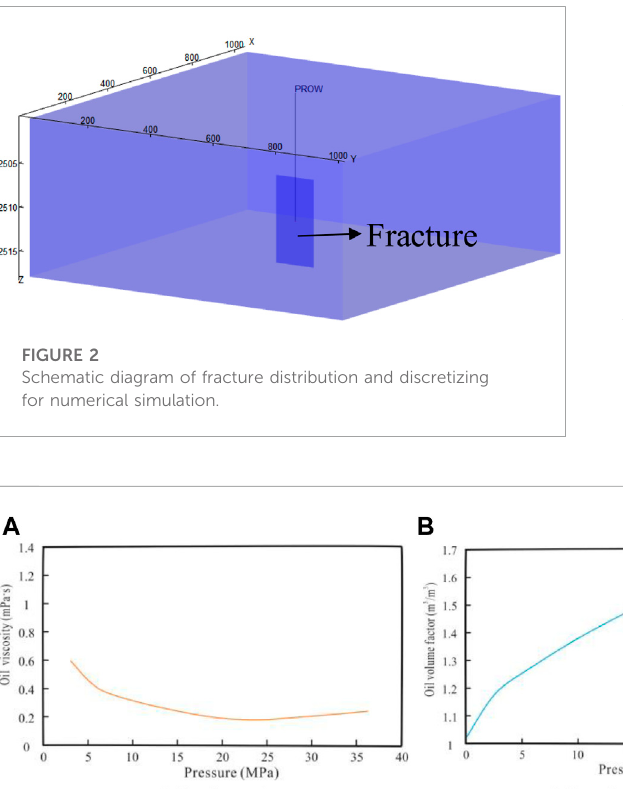
FIGURE 3 Curves of oil properties versus